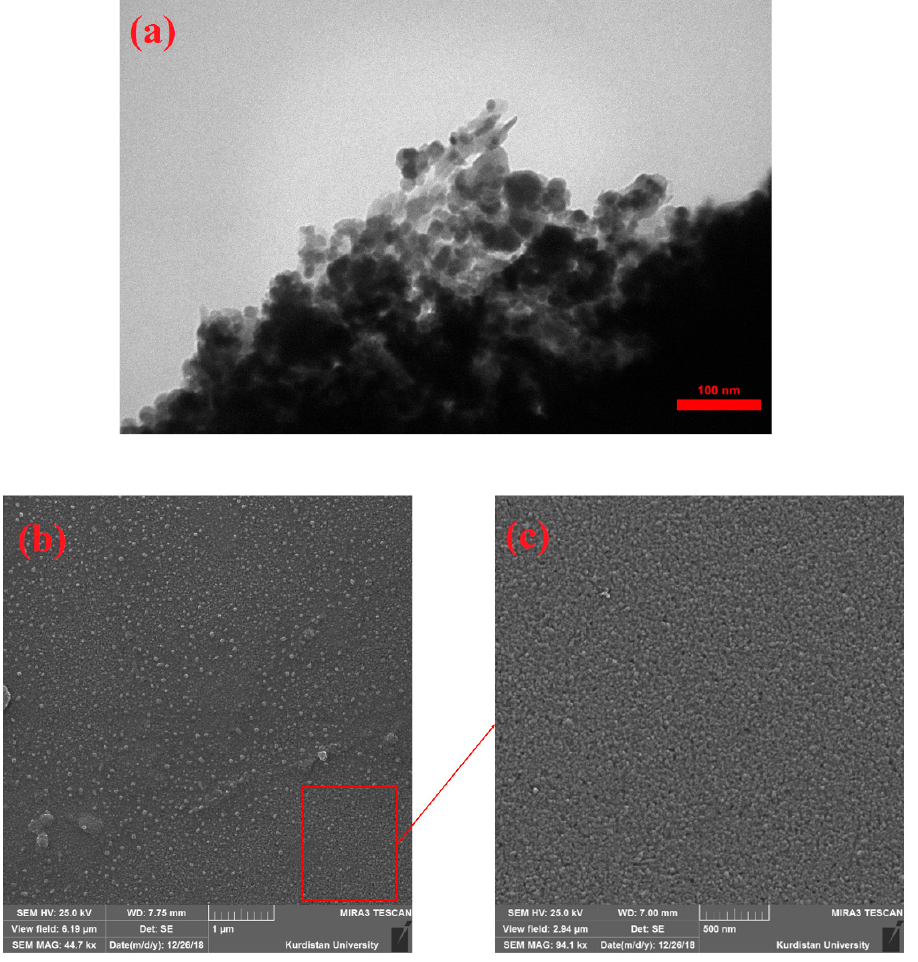
Figure 3. ( a ) TEM and ( b , c ) SEM images.